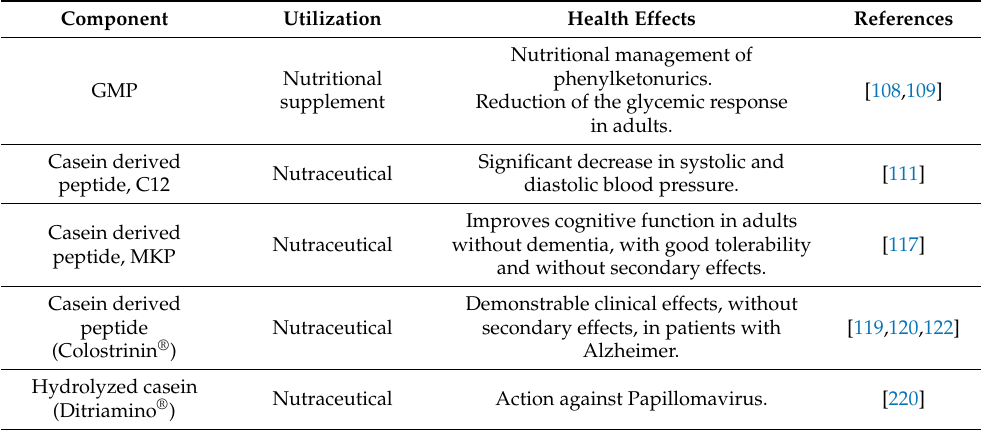
Table 3. Examining nitrogenous components of breast milk used in health applications, summary of evidences (clinical trials, cohort studies, and